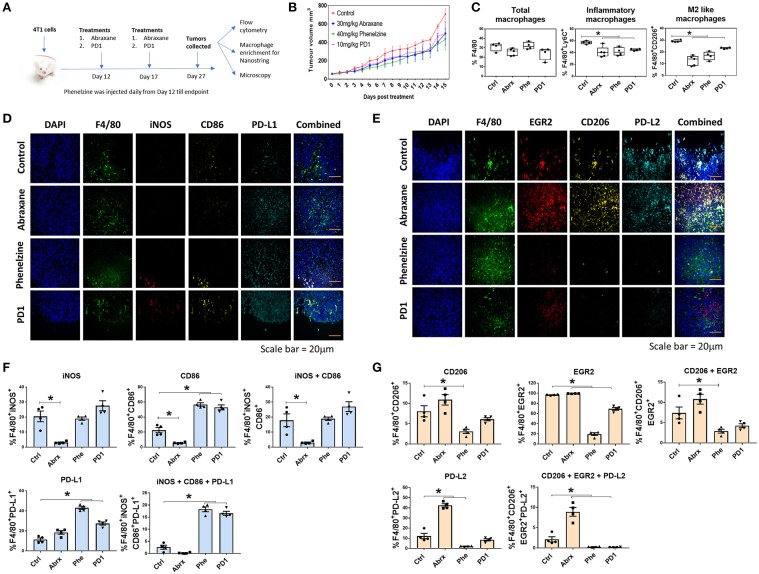
Phenelzine treatment polarizes macrophages in the tumor microenvironment toward an M1 phenotype. (A) Treatment regime using the BALB/c 4T1 breast cancer model. (B) Tumor volumes of mice treated with vehicle control, Abraxane, Phenelzine or PD1 (n = 4/5). (C) Flow cytometry for total macrophages, inflammatory macrophages, and M2-like macrophages in the TME. *p < 0.05, Mann–Whitney t-test (n = 4/5). Representative images of (D) M1 and (E) M2 staining of FFPE tumor tissues in 4T1 mouse model. (F) Sections of primary 4T1 tumors were fixed and IF microscopy performed probing with M1 focused primary antibodies to F4/80, iNOS, CD86, and PDL1 with DAPI (green = F4/80 red = iNOS, yellow = CD86, cyan = PDL1, blue = DAPI). The population % of F4/80 cells positive for iNOS, CD86 and PDL1 was measured using ASI's mIF system. Representative images for each dataset are shown. Graphs plots represent the % population (n ≥ 500 cells profiled per a group, n = 4 mice). (G) Section of primary 4T1 tumors were fixed and IF microscopy performed probing with M2 focused primary antibodies to F4/80, EGR2, CD206, and PDL2 with DAPI (green = F4/80 red = EGR2, yellow = CD206, cyan = PDL2, blue = DAPI). The population % of F4/80 cells positive for EGR2, CD206, and PDL2 was measured using ASI's mIF system. Representative images for each dataset are shown. Graphs plots represent the % population (n ≥ 500 cells profiled per a group, n = 4 mice).